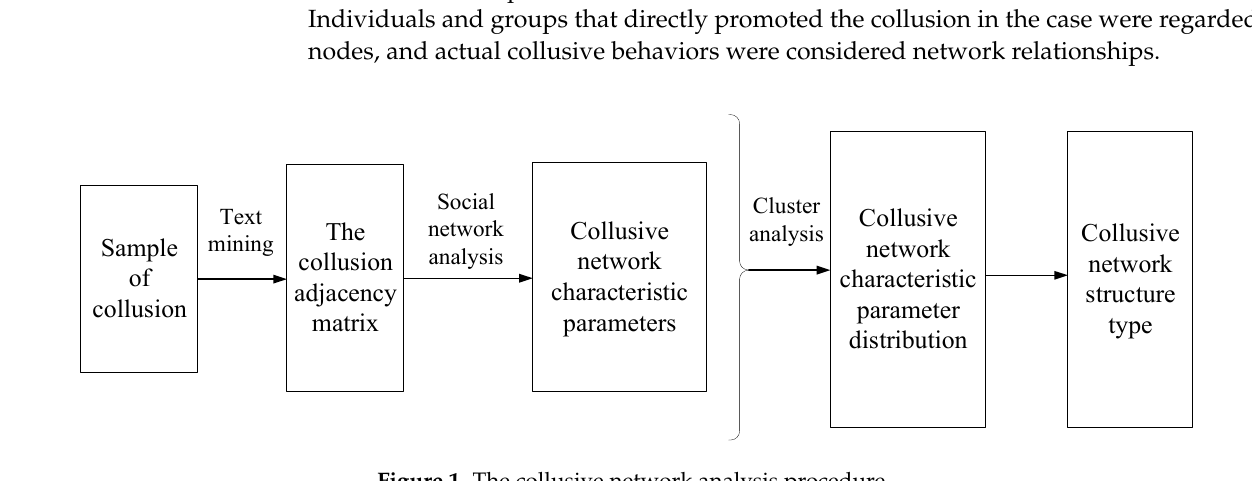
Figure 1. The collusive network analysis procedure.